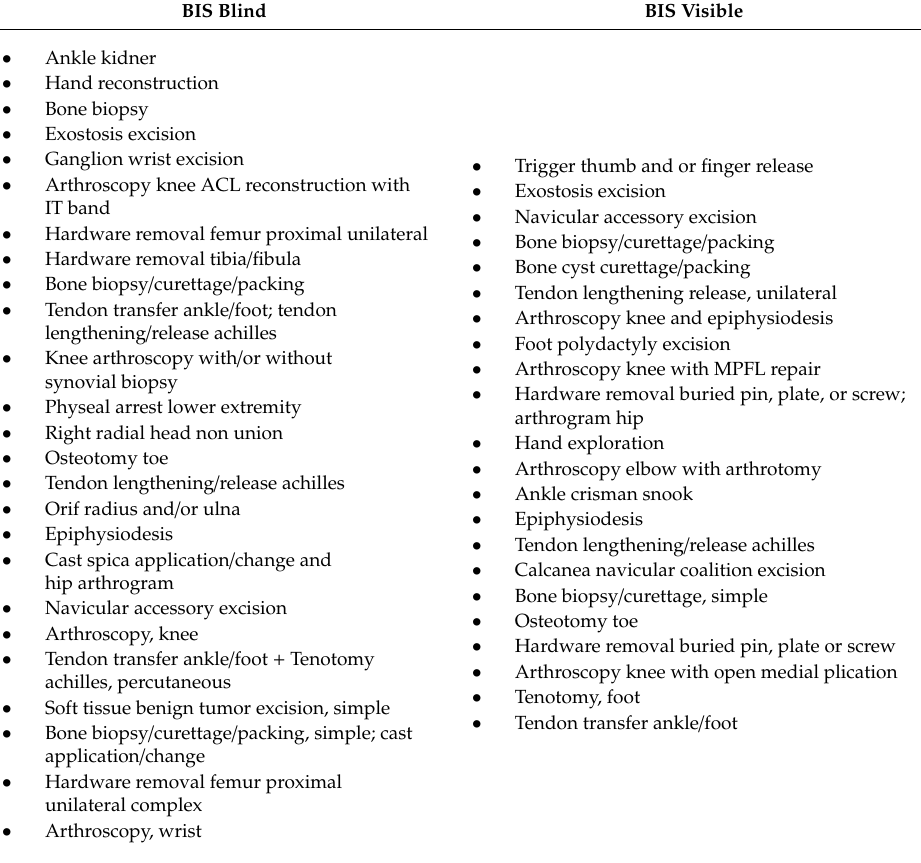
Table 3. Procedures for Bispectral Index (BIS) Blind and BIS Visible Groups BIS Blind